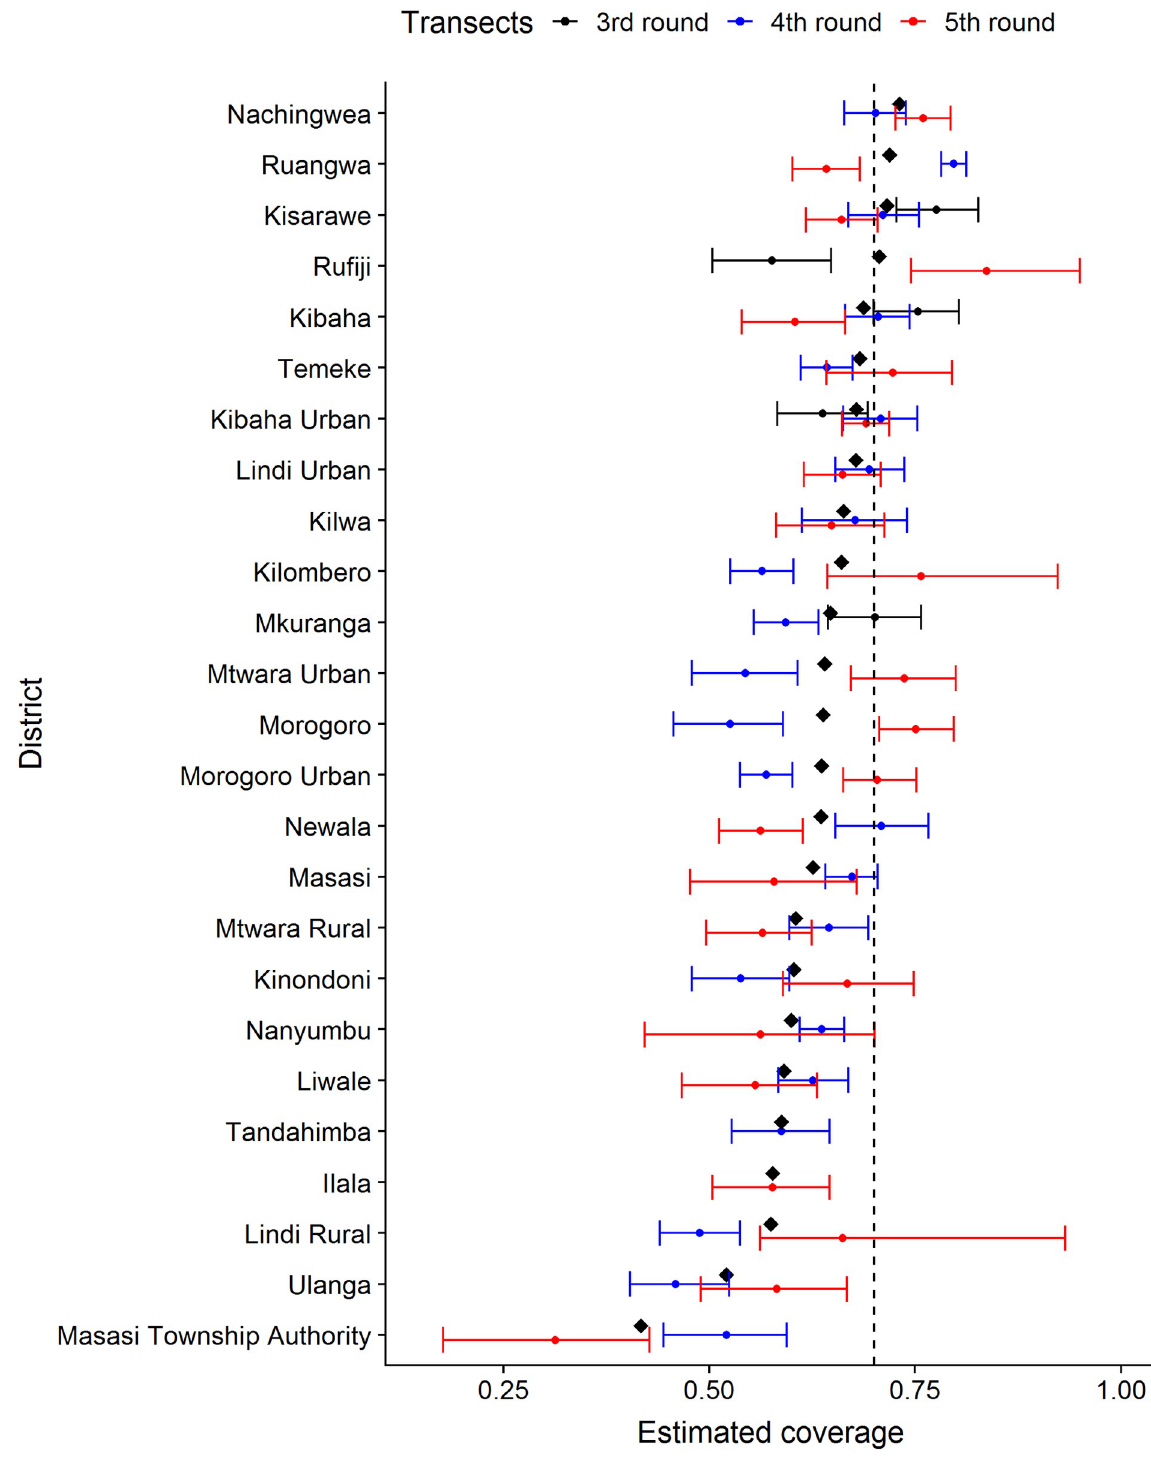
Fig 4. Coverage achieved during campaigns in each district from 2013 to 2017 (third to fifth round of vaccinations) calculated directly from transects without accounting for the pup:adult ratio (PAR) and excluding villages without transect data. Black diamonds represent mean coverage across the three rounds. The black dashed line represents the target 70% vaccination coverage threshold.